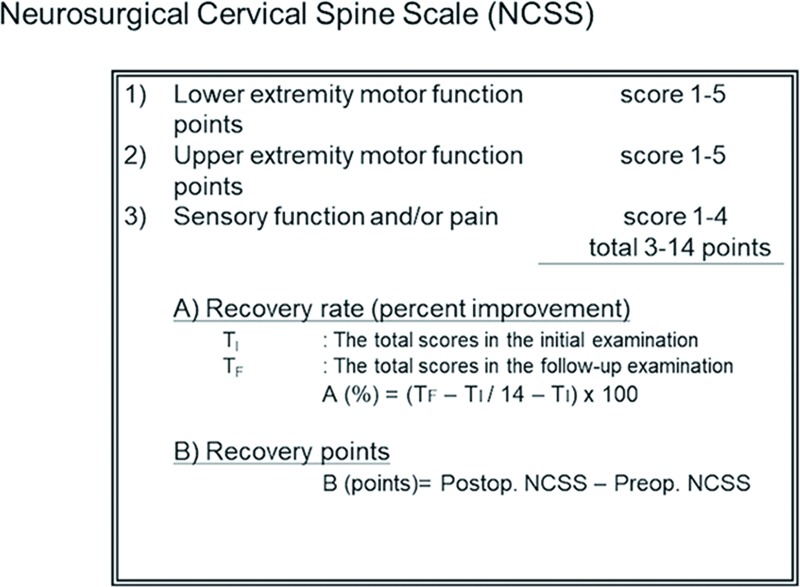
The neurosurgical cervical spine scale (NCSS) grading and scoring system for neurological function in degenerative cervical spine disease.On this scale, healthy individuals receive a score of 14 points. This scale is divided into three categories evaluating motor and sensory function. The higher the NCSS score, the better the functional status of the patient at the time of the assessment. The recovery rate (%) indicates the percent improvement of the patient. In order to clearly understand the patients’ characteristics, “recovery points (points)” were also used in this study. Postop., postoperative; Preop., preoperative.